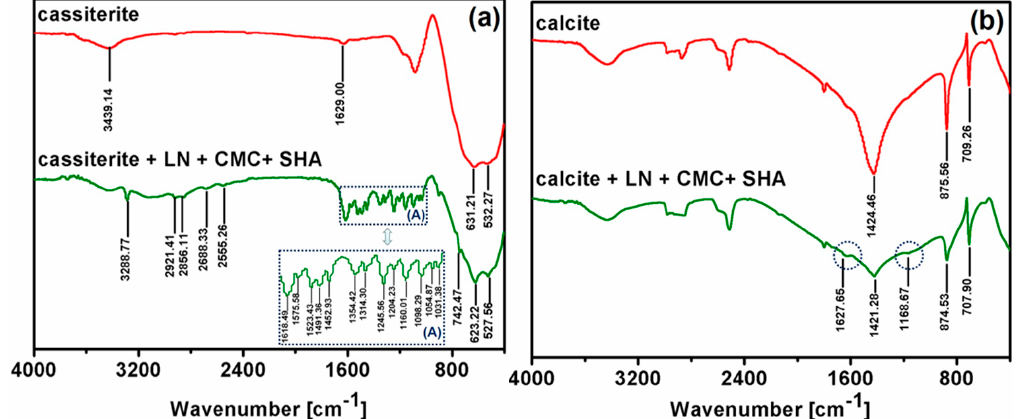
Figure 8. FTIR spectra of cassiterite ( a ) and calcite ( b ) untreated and treated by flotation reagents.